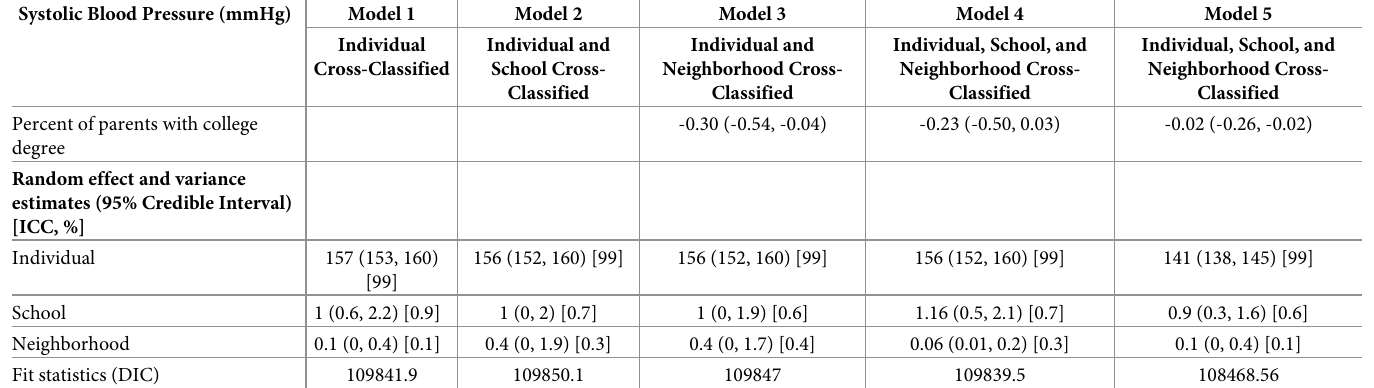
effects (neighborhood-level random effect: 0.4%). In null models predicting diastolic blood pressure, not accounting for fixed effects at any level, individual level random effects accounted for 99% of the variance, school for 0.1% and neighborhoods for 0.1% (S3 Table, Model 4). Similar to results for systolic blood pressure, with the inclusion of fixed effects at each level, the individual, school, or neighborhood-level random effects did not substantially change (Table 4). We then examined the associations of characteristics of individuals, schools and neighborhoods with young adult systolic blood pressure, and found that compared to hypertension, many significant relationships did not remain. For example, students with over- weight BMI ( β = 5.03; 95% CI: 4.52–5.55) or obese BMI ( β = 9.42; 95% CI: 8.93–9.89) had higher systolic blood pressure. At the neighborhood level, in the fully adjusted individual, school, and neighborhood cross-classified model, (Table 3, Model 5) percent of students Non- Hispanic White was associated with lower systolic blood pressure ( β = -0.07; 95% CI: -0.21, -0.07). Other neighborhood-level factors and school-level fixed effects were not associated with either systolic or diastolic blood